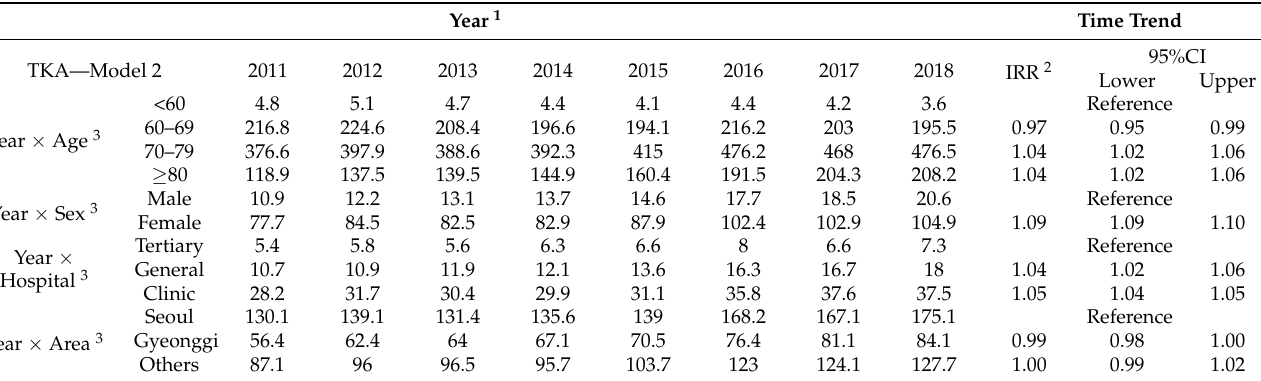
Table 2. Model 2—Poisson regression analysis according to investigation of potential inter-group discrepancies in time trend